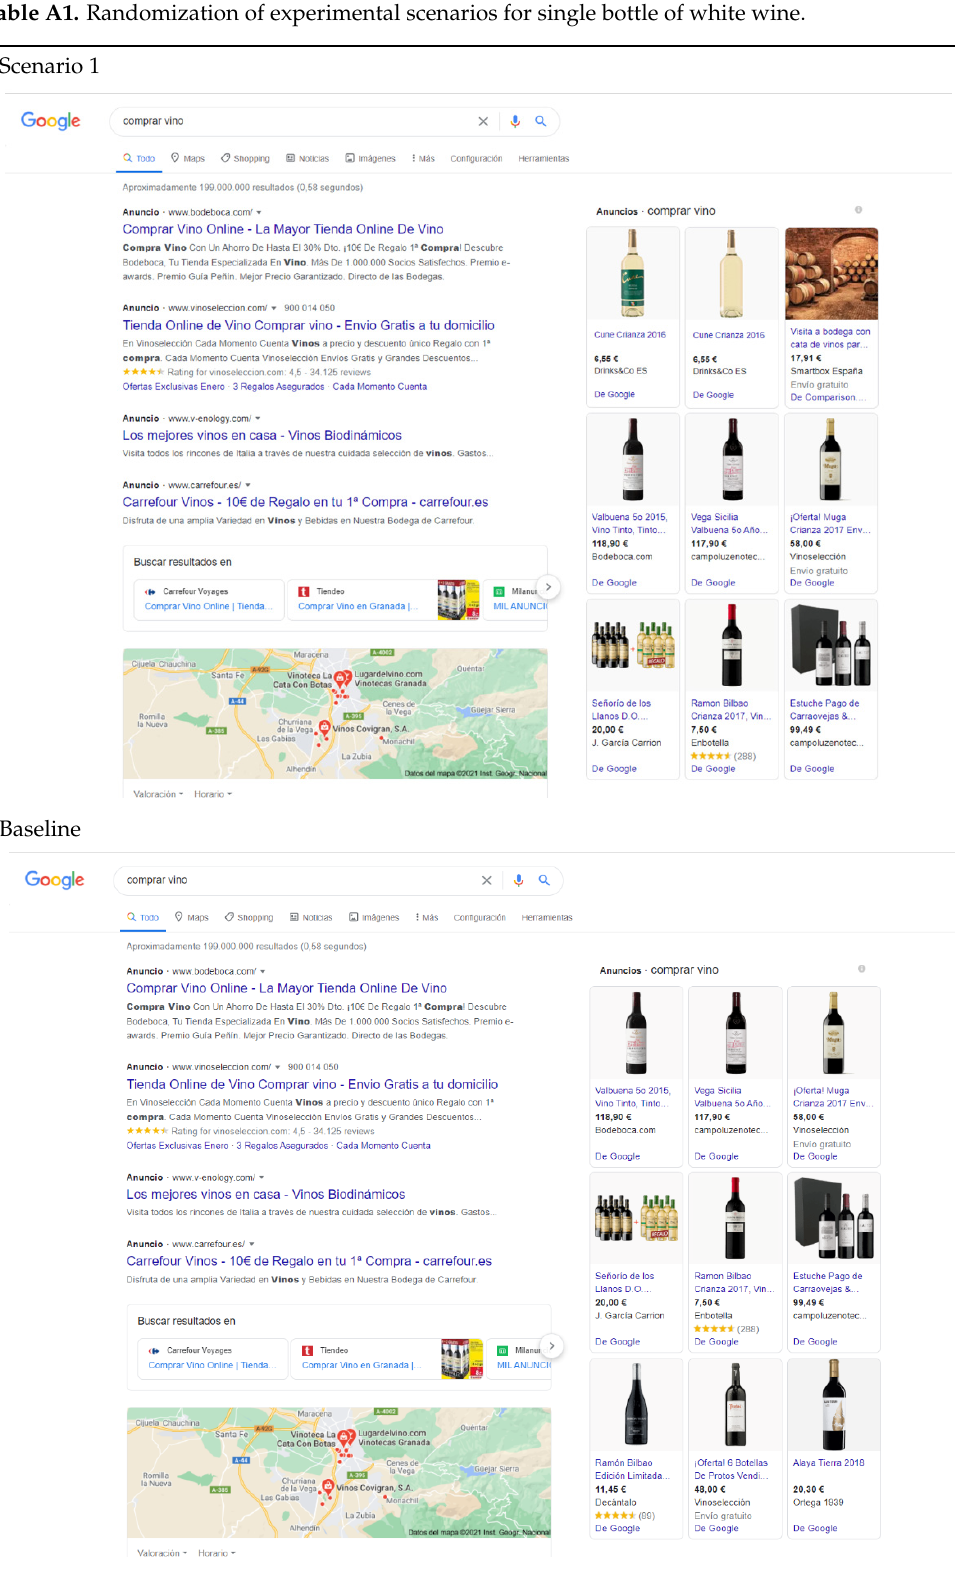
Table A1. Randomization of experimental scenarios for single bottle of white wine.